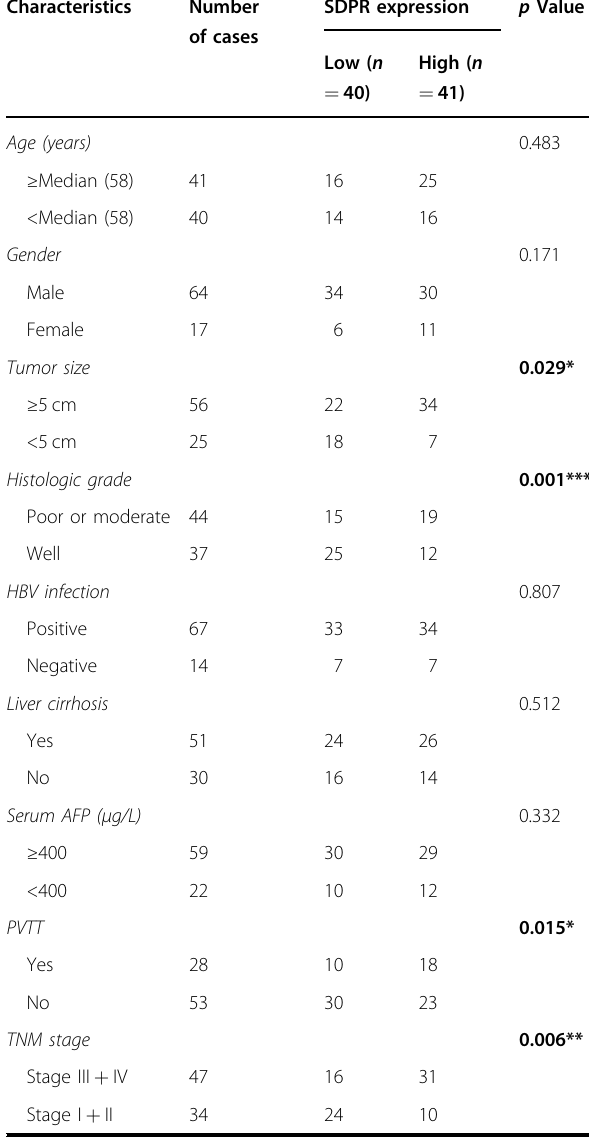
Table 1 Clinical characteristics of 81 HCC patients according to SDPR expression